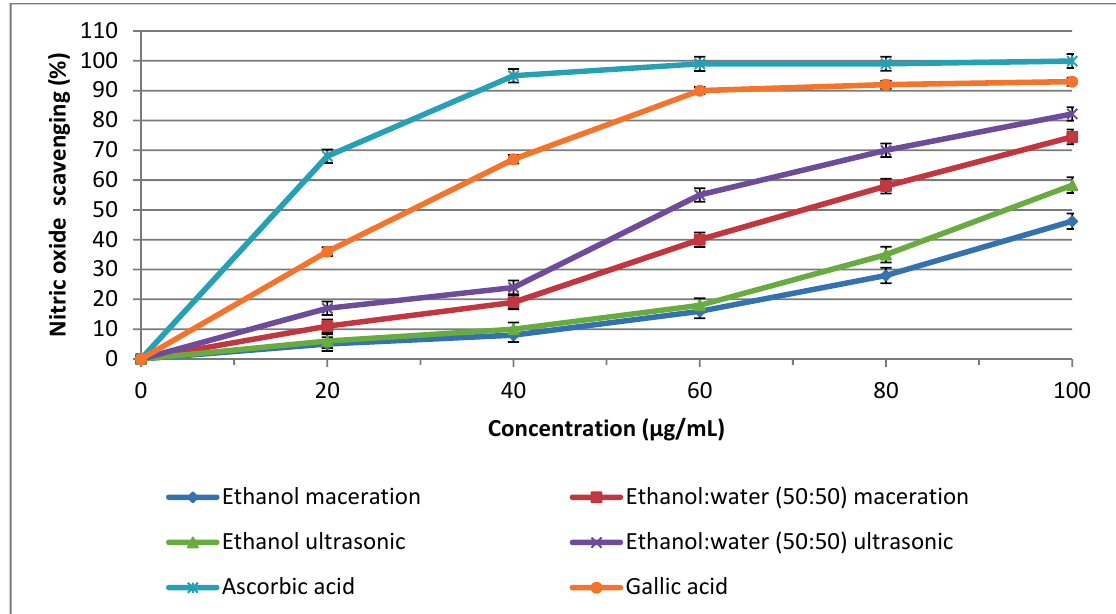
Figure 2. Nitric oxide scavengi . ng activity of Hashemi rice bran , extracts from different extraction methods. Error bars represent standard errors of the mean ( n = 3).